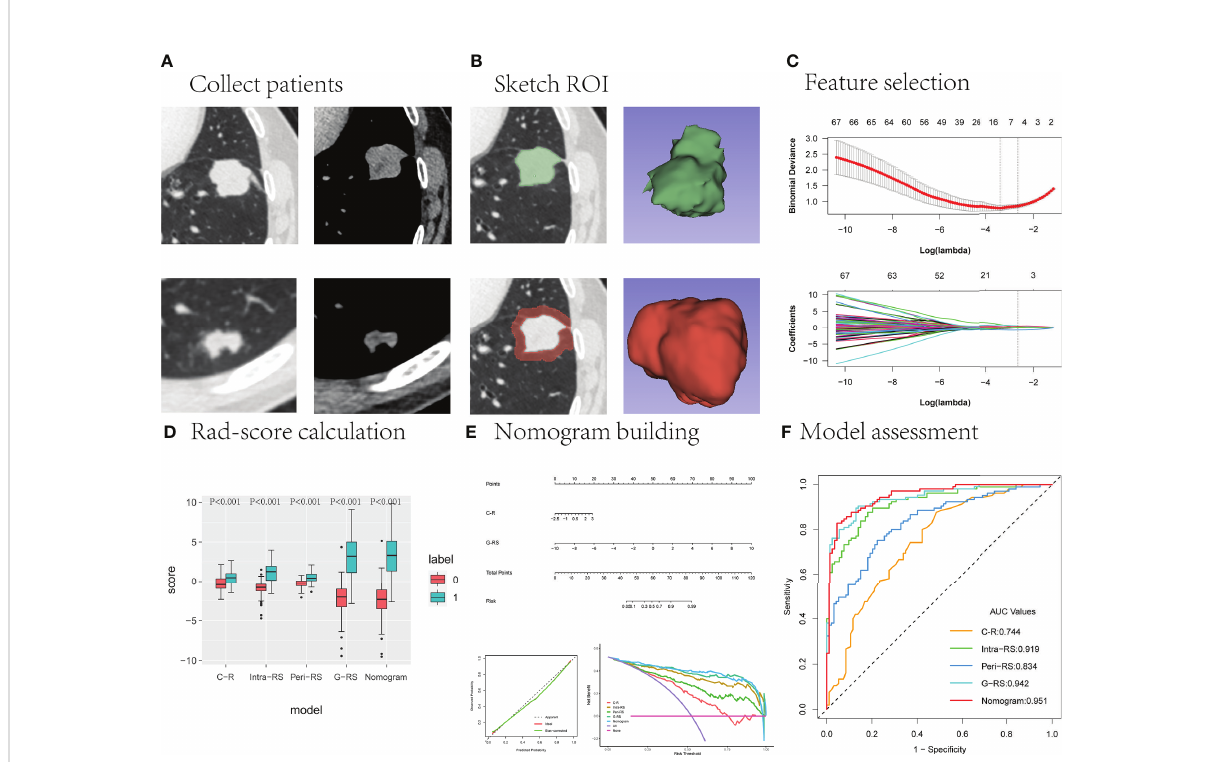
FIGURE 2 The main research process. (A) The upper and lower layers are CT images of the lung window and mediastinal window in patients with lung cancer and benign lung nodules, respectively. (B) Outline of the intranodal and perinodal areas in a patient with lung cancer. (C) Useful radiomics features are fi ltered from the high-dimensional features. (D – F) The performance of the different models is compared and the best model is selected to construct column line graphs and evaluate clinical